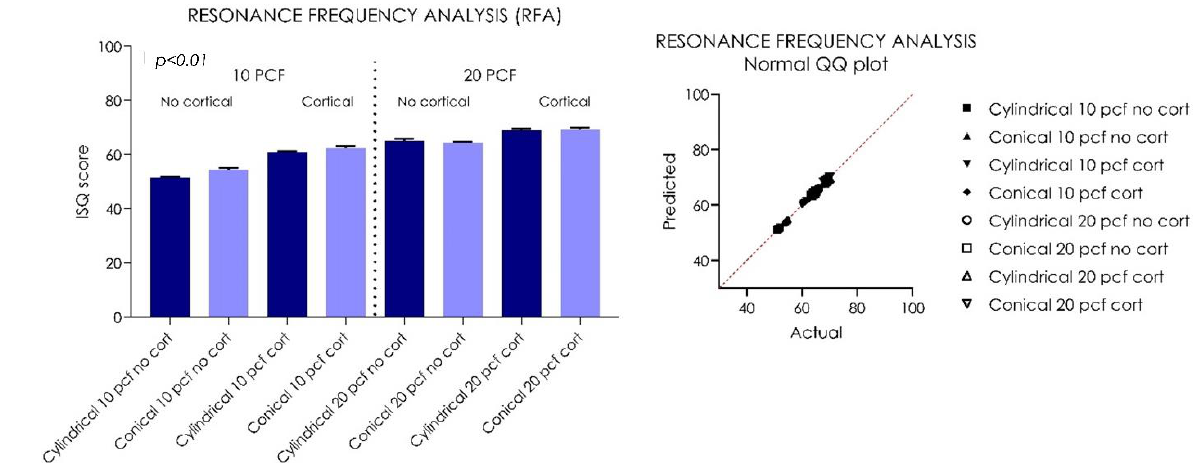
Figure 5. Graph and QQ plot values distribution showing the resonance frequency analysis (RFA) values of the tested cylindrical and tapered implants.